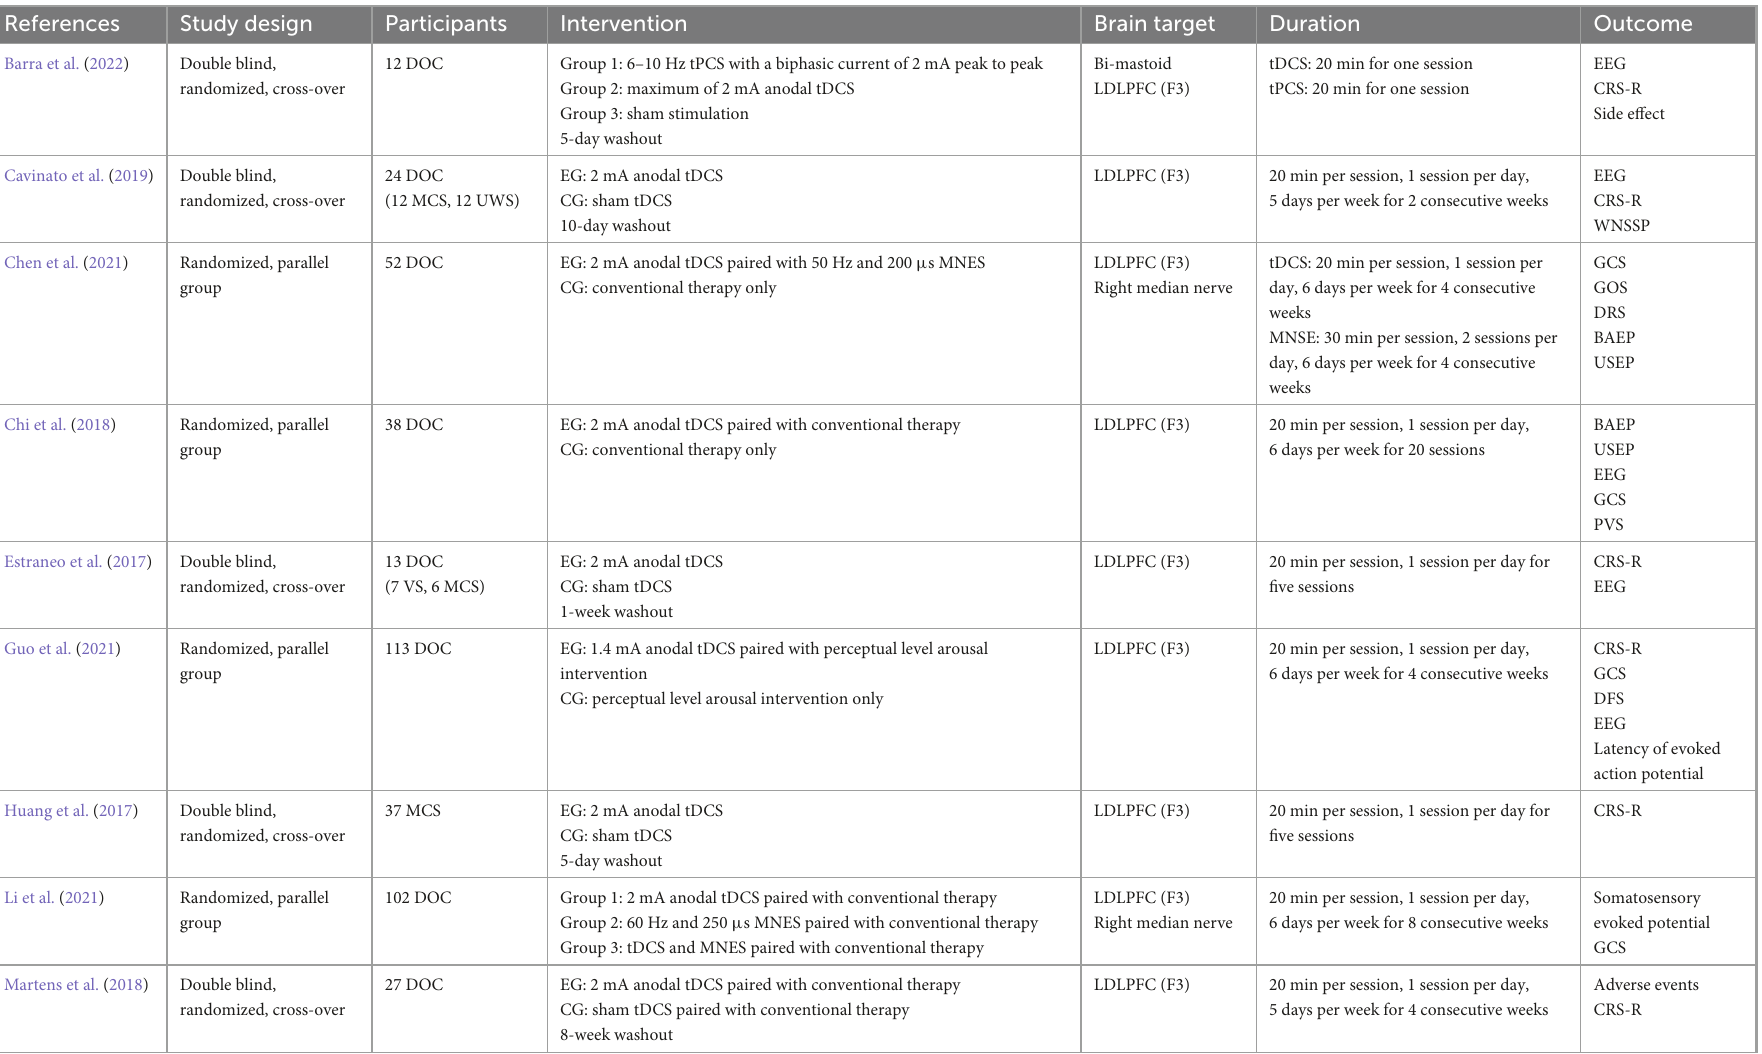
TABLE 1 Characteristics of included studies in this